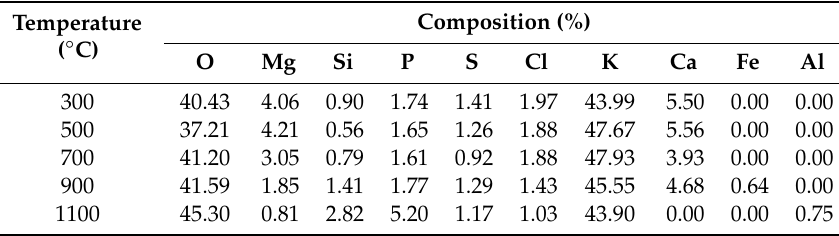
Table 2. Elemental composition of calcined CPK by